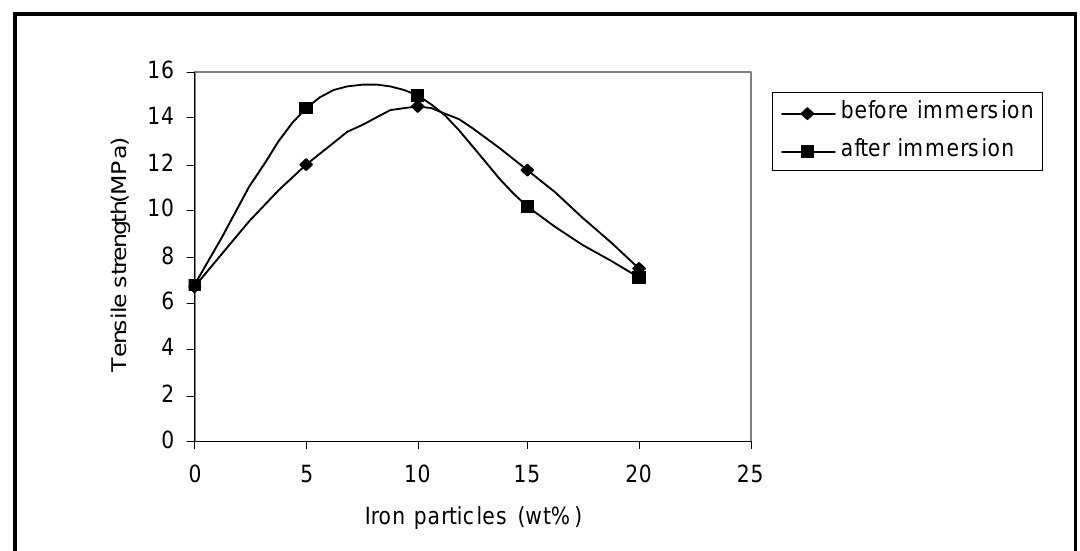
Fig. 3: Tensile strength (MPa) as a function Iron particles